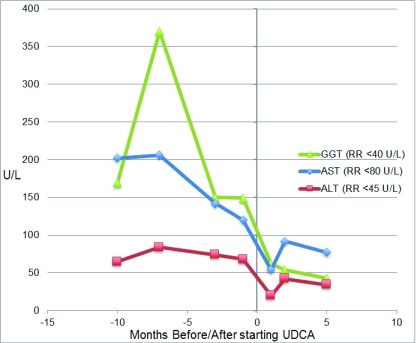
Graph of hepatic function parameters from Case 2 in the months before and after starting ursodeoxycholic acid (UDCA).This demonstrated a marked improvement in liver function parameters.